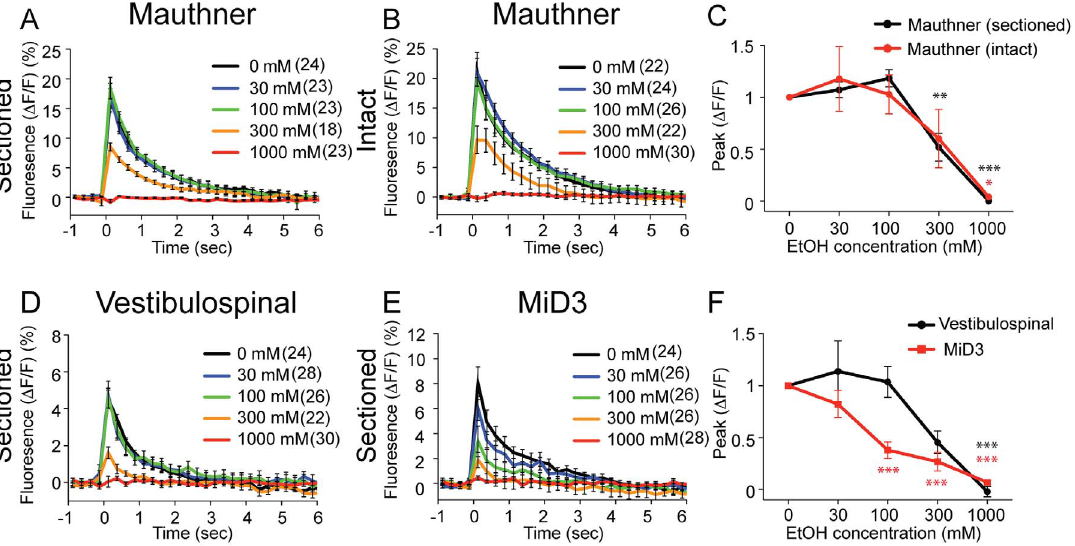
Figure 3. Activity of reticulospinal neurons in ethanol. Fluorescence intensity of Mauthner neurons (A–C), vestibulospinal neurons (D, F) and MiD3 neurons (E, F). Sound/vibration stimuli were applied to sectioned (A, D, E) or intact larvae (B) bathed in 0, 30, 100, 300 and 1000 mM ethanol. The black, blue, green, orange and red lines correspond to 0, 30, 100, 300, and 1000 mM ethanol, respectively. The peak of D F/F normalized to values at 0 mM was plotted against the EtOH concentration in C and F. (*P , 0.05, **P , 0.005, ***P , 0.001 versus 0 mM ethanol). Six Mauthner neurons, eight vestibulospinal neurons, and five MiD3 neurons were measured. Stimuli were applied and calcium transients were elicited at each concentration 2– 5 times. The numbers of samplings are shown in